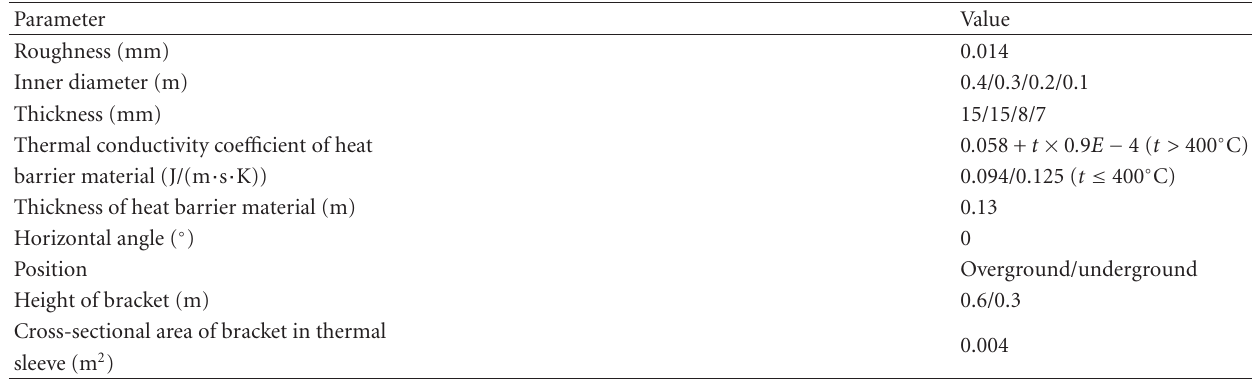
Table 8: Basic parameters of pipeline.